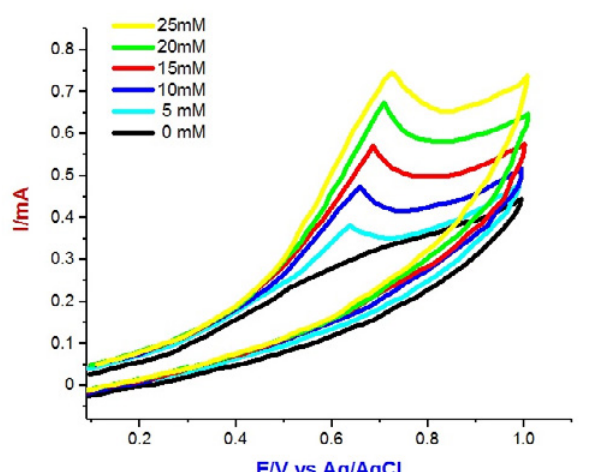
Fig. 6. Cyclic voltammograms of a NAA modified electrode(P type) at 50 mV/s in the absence and presence of 5, 10, 15, 20 and 25 m mol/ L